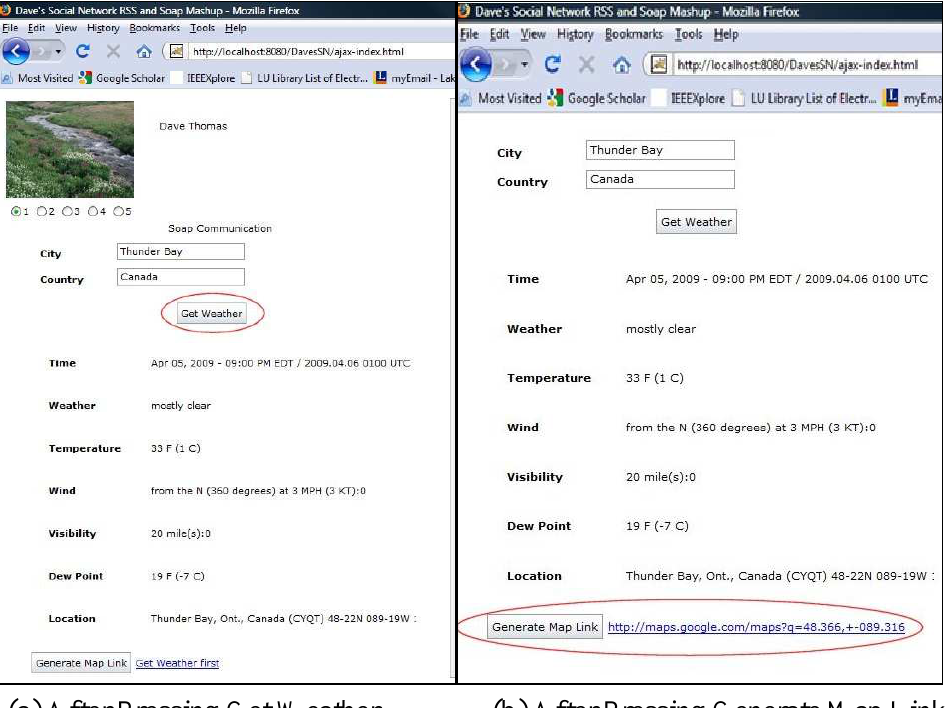
(a) After Pressing Get Weather (b) After Pressing Generate Map